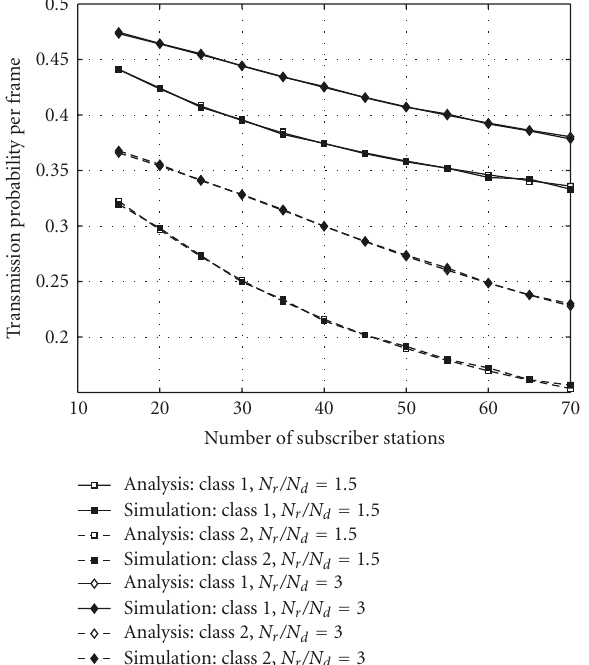
Figure 8: REQ transmission probability of SS versus the number of SSs with equal bandwidth allocation priority, and di ff erentiated channel access parameters: W 0,1 = N r , W 0,2 = 2 N r , W x ,1 = 2 4 W 0,1 and W x ,2 = 2 8 W 0,2 .